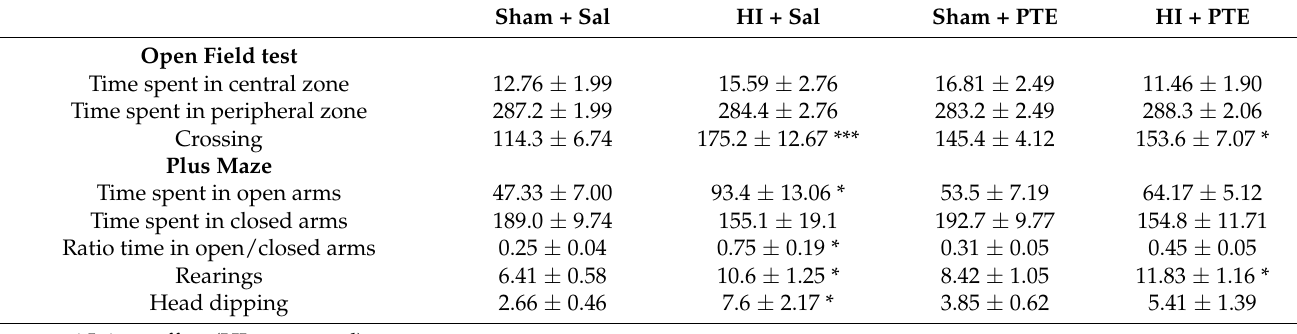
Table 1. Open Field and Elevated Plus Maze performance. Data are expressed as means ± SE. * Injury effect (HI vs. control). Sham + Sal ( n = 12); HI + Sal ( n = 10); Sham + PTE ( n = 14); HI + PTE ( n = 12). Significance was accepted whenever p < 0.05 (* or #), p < 0.01 (** or ##), or p < 0.001 (*** or ###) (one-way